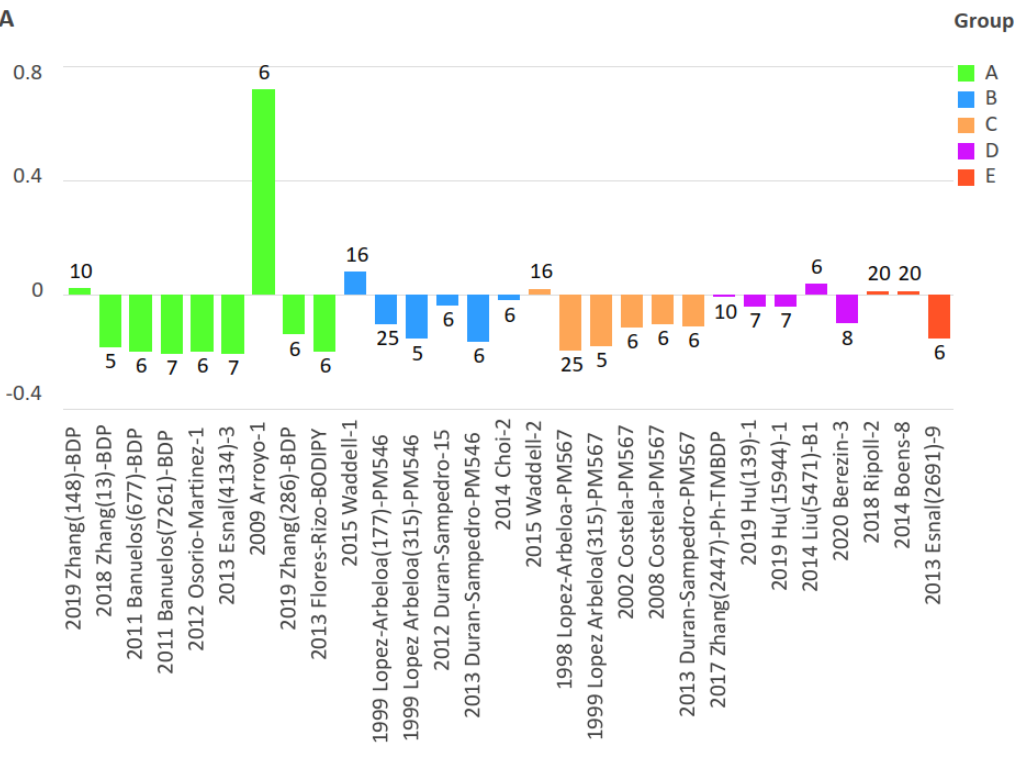
Figure 11. Solvatochromic sensitivity parameter A for the duplicates of the studied dataset, sol- vent coun t ≥ 1 0 for a target dataset, and solvent count ≤ 9 for an extra dataset.